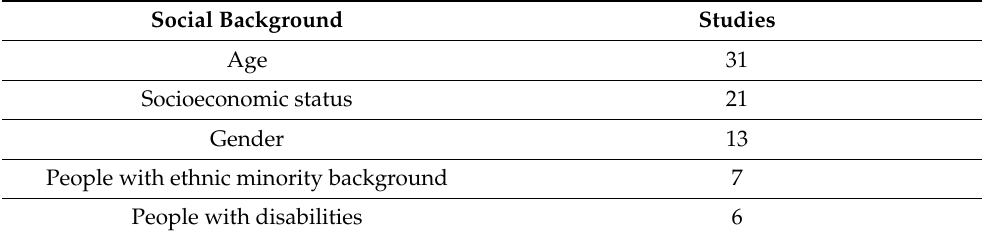
Table 3. Number of studies structured according to their main foci. Social